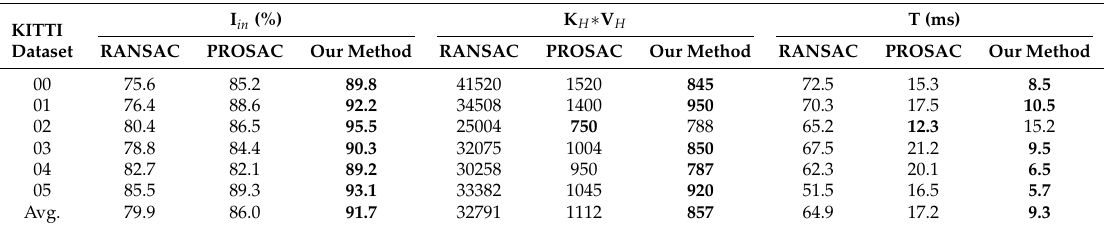
Table 1. Comparison of efficiency of the estimation algorithm. Average computational time for a single frame on an Intel-i5 2.30GHz CPU, four cores are